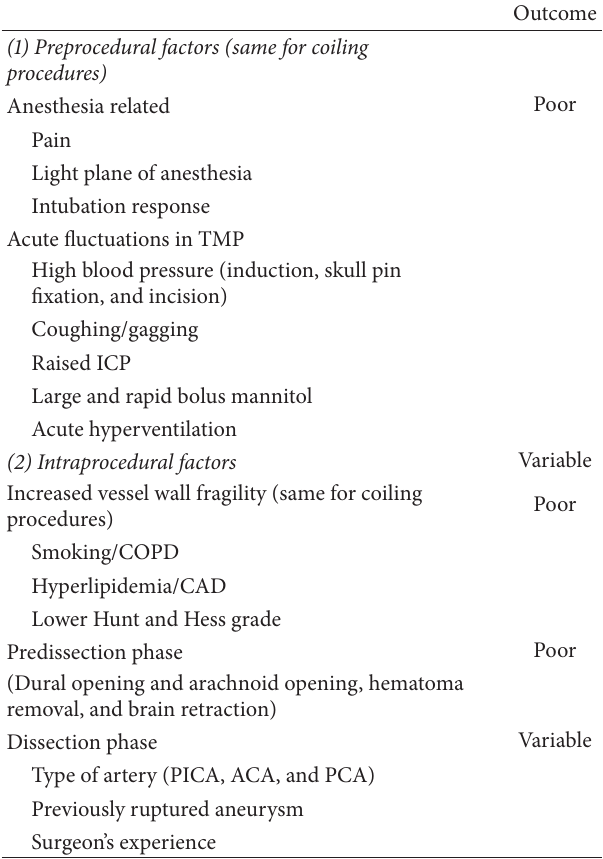
Table 1: Intraoperative variables contributing intracranial aneu- rysm